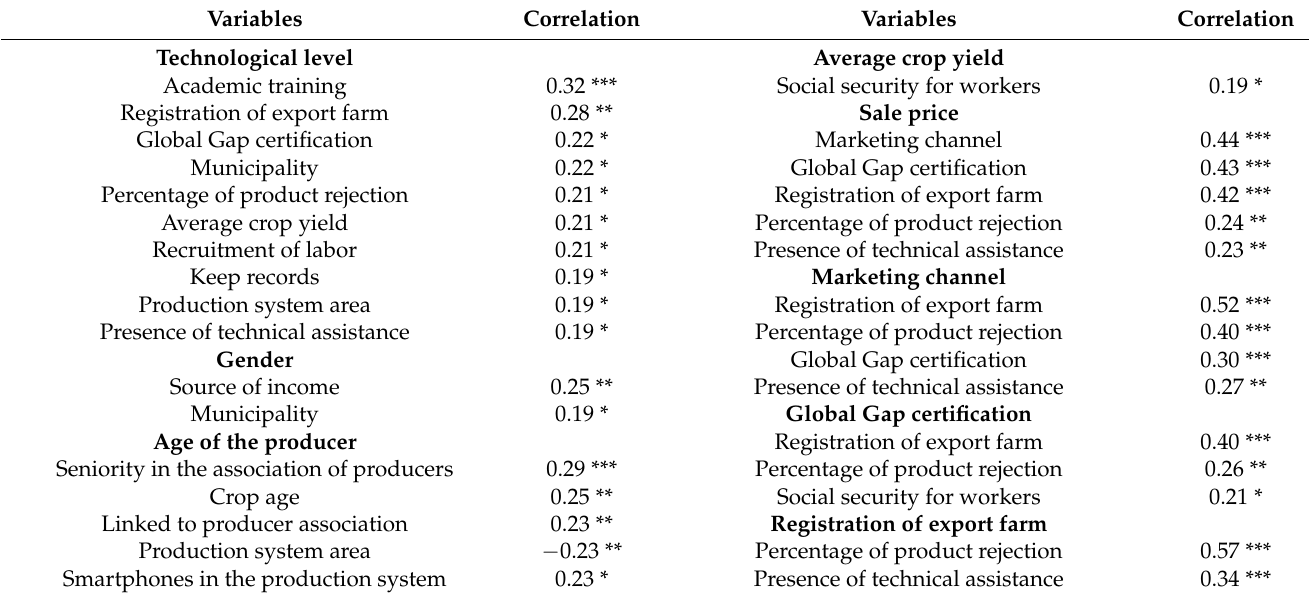
Correlation between Variables Used for the Characterization of the Avocado Producers